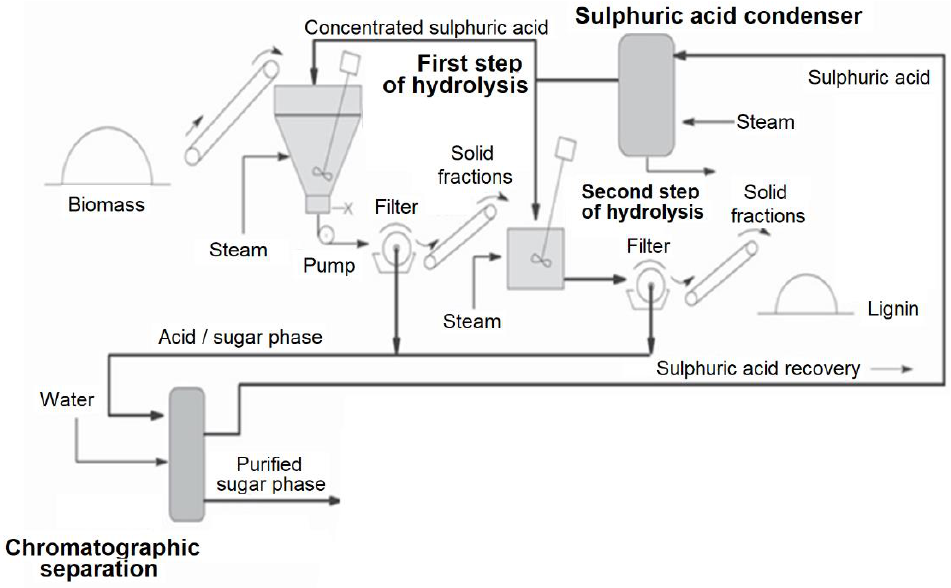
Figure 1. Scheme of the installation of conversion of lignocellulose into sugars [21].